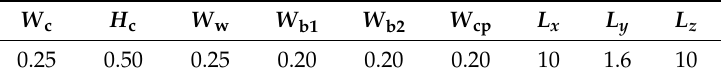
Table 2. Hotspot parameters and their ranges.